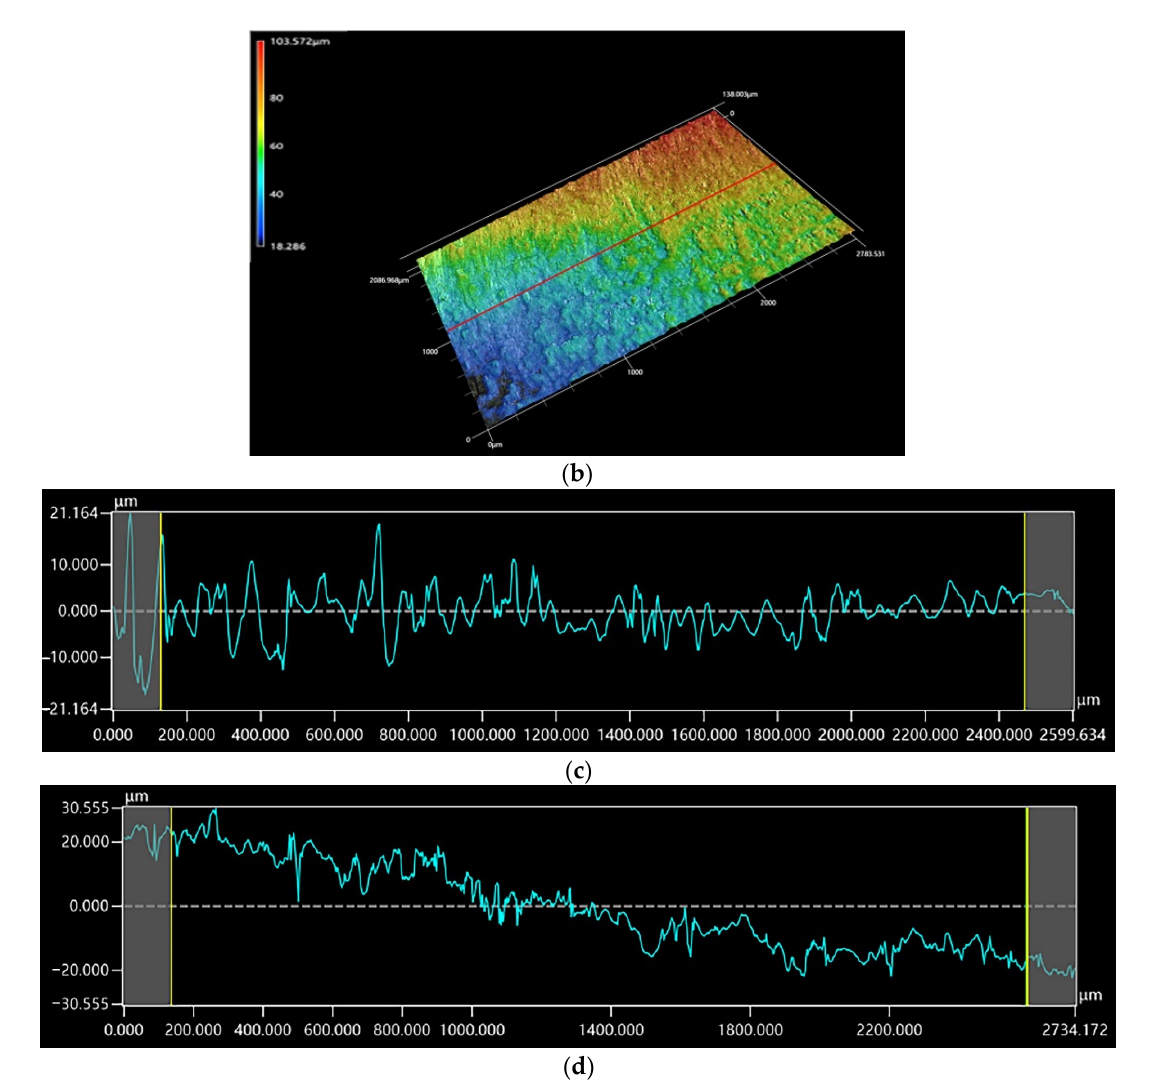
Figure 12. 3D morphologies of the CoCrFeNiMn HEA coatings after wear test: ( a ) coating at 55 A, ( b ) coating at 60 A and wear depth variation through line scanning of the HEA, coating at ( c ) 55A and ( d ) 60A.